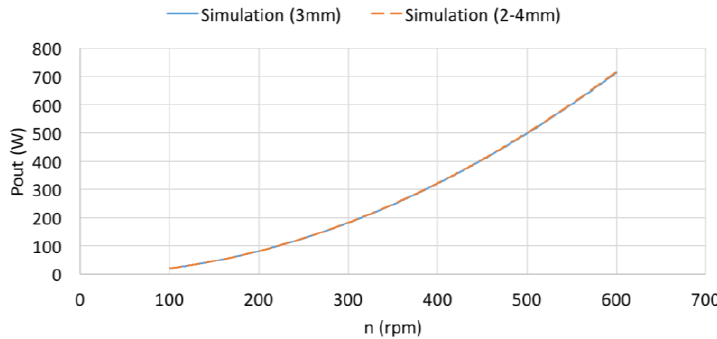
Figure 17. Plot versus the speed of the output power in the simulation model with 3 mm air gaps compared to that of the simulation model with 2–4 mm air gaps.